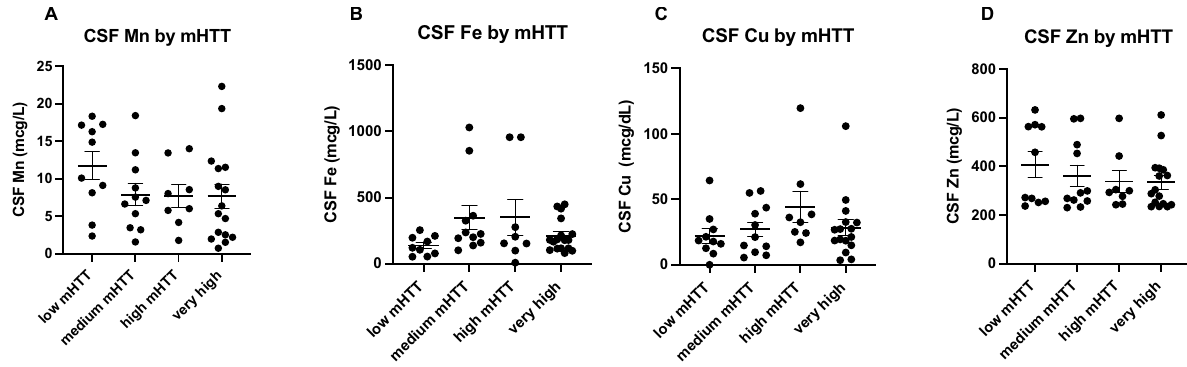
Figure 7. Cerebrospinal fluid metal levels by mutant Huntingtin (mHTT) accumulation in HD participants. mHTT was categorized into low (0-10fM), medium (11–49 fM), high (50–100 fM), very high (101 + fM). Differences in CSF ( A ) Mn, ( B ) Fe, ( C ) Cu and ( D ) Zn by mHTT concentration were assessed using 1-way ANOVA. Data are shown as individual data points with the mean ±